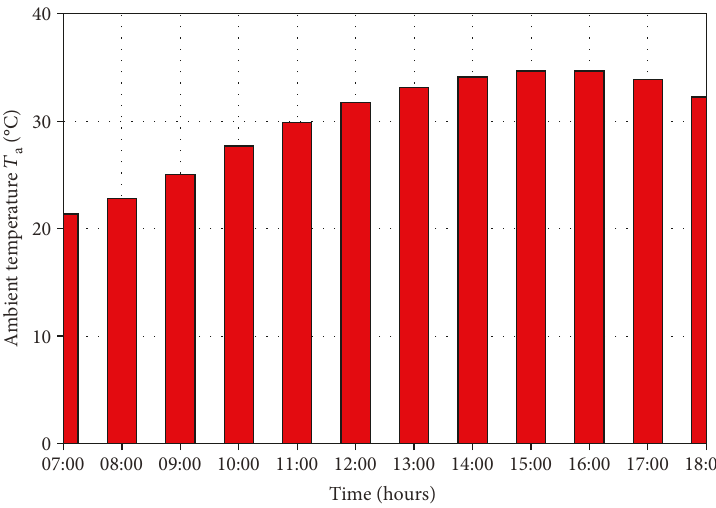
Figure 5: Yearly hourly average values of ambient temperature.